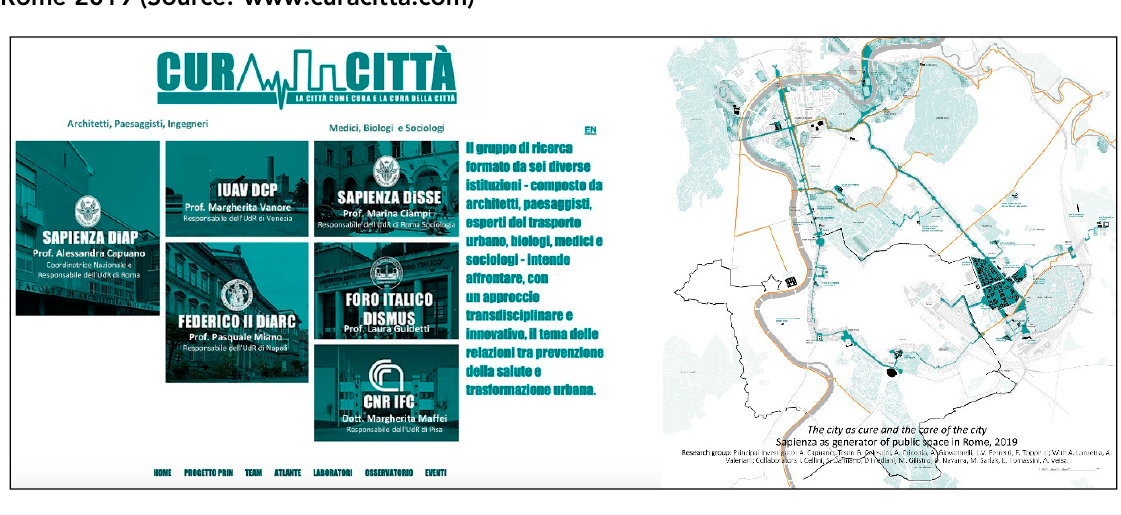
Figure 4. ‘The city of cure and the care of the city’: Sapienza as generator of public space in Rome 2019 (Source: www.curacitta.com)